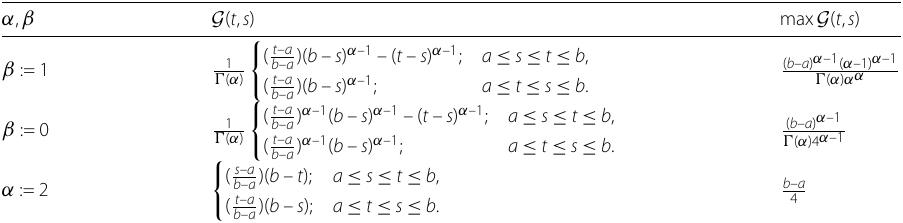
Table 2 Corresponding Green functions and their maximums α ,